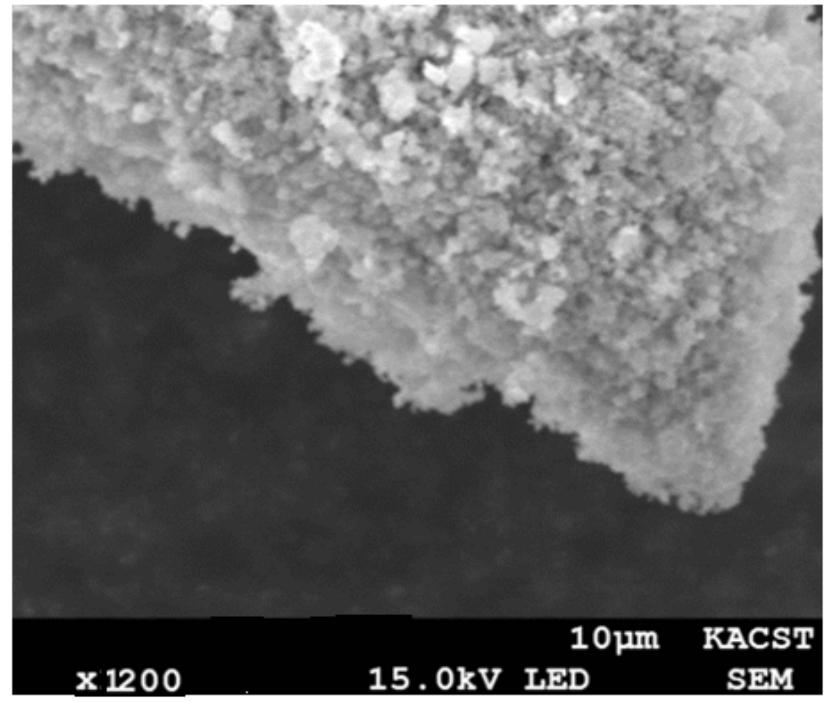
Figure 9. SEM image of the fresh 5Ni+4Gd/YZr catalyst.